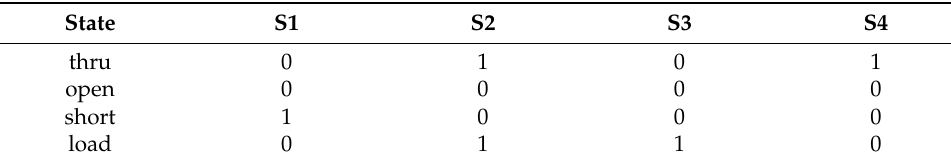
Table 2. Working principle table.